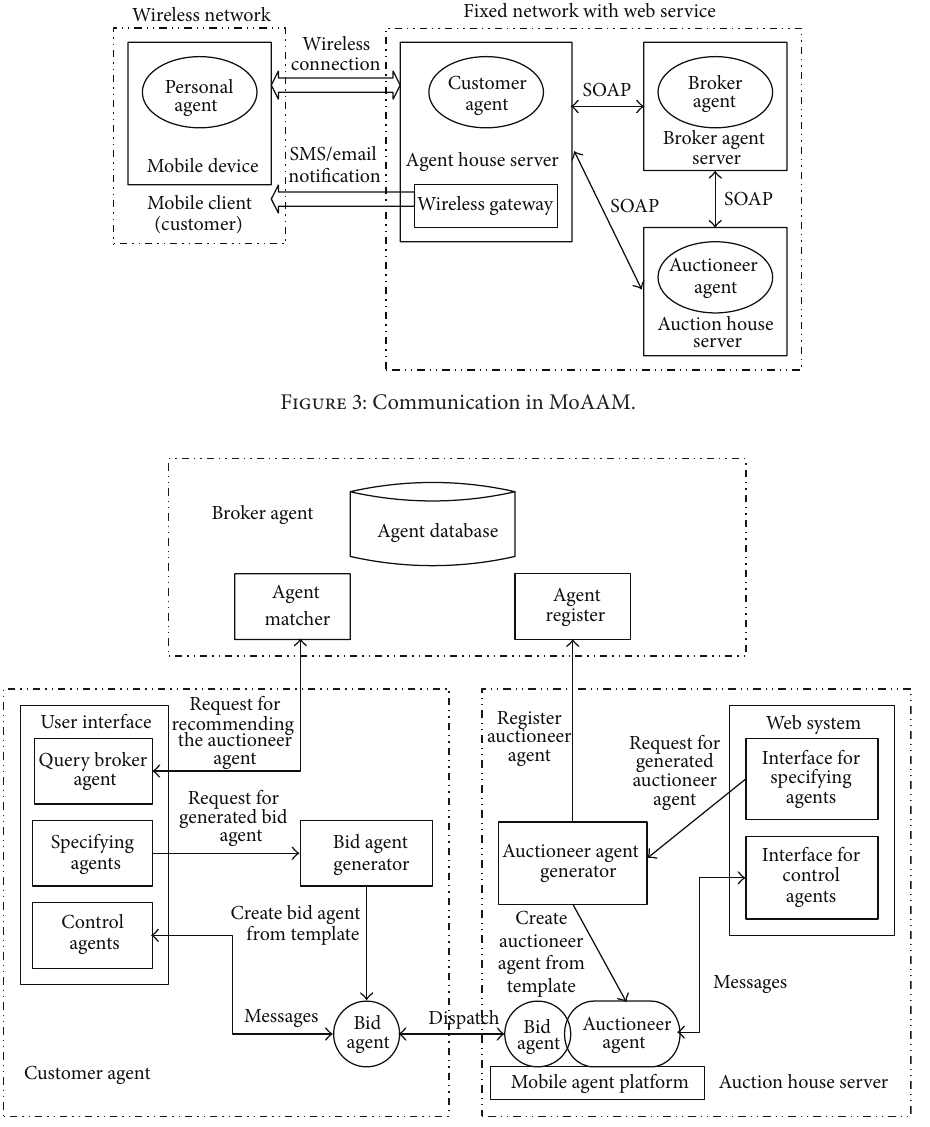
Figure 4: Architecture of